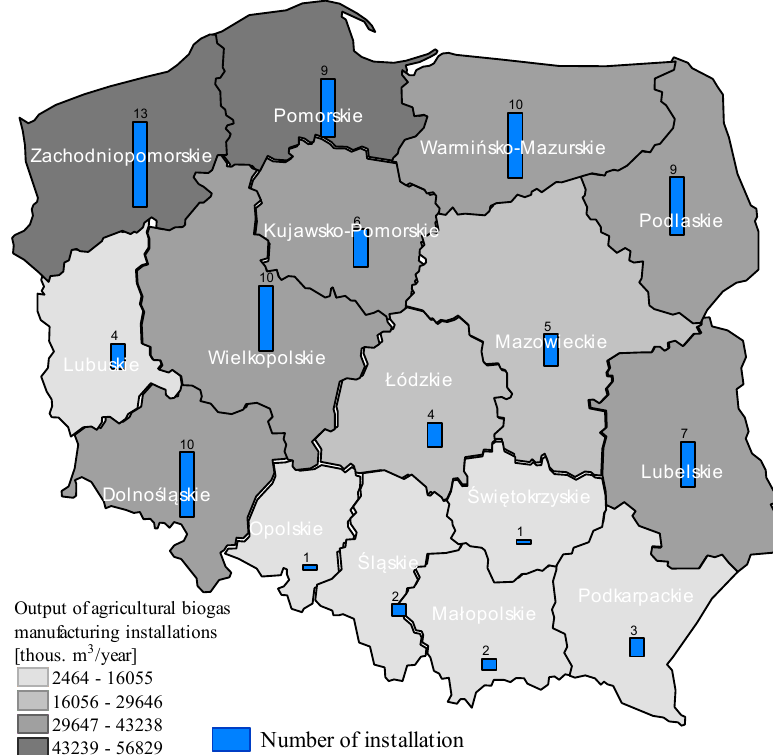
Figure 1. The number and capacities of agricultural biogas plants in Poland broken down by provinces (as of 24 January 2019) [65].